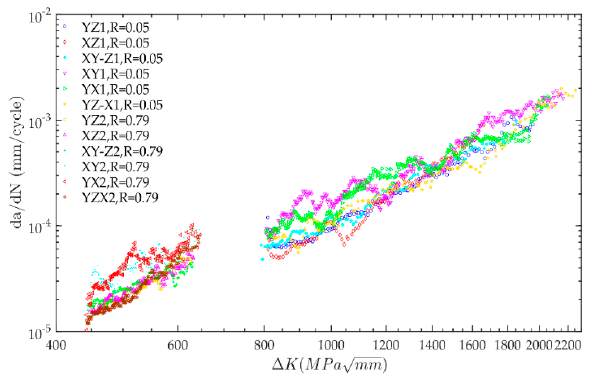
Figure 6. Relationship between crack growth rate, da / dN , and stress intensity factor range, ∆ K.